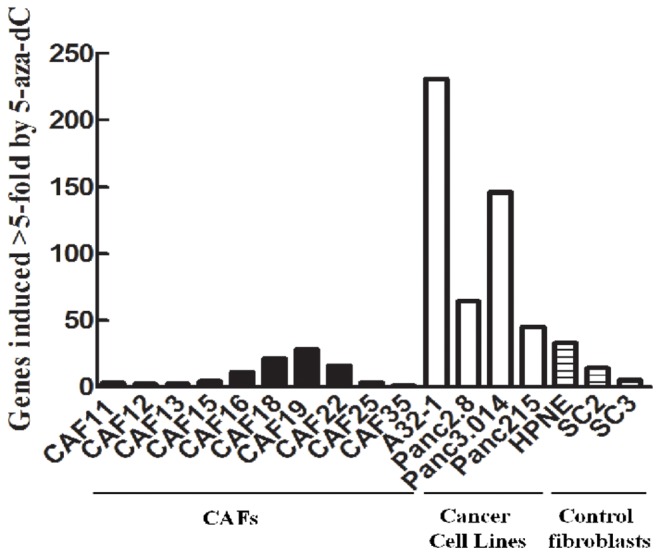
Number of genes induced by 5-aza-dC treatment in individual pancreatic CAFs, control fibroblasts and cell lines.An average of 123±86 genes were induced 5-fold or more by 5-aza-dC treatment in four pancreatic cancer cell lines, 9±10 genes in ten pancreatic CAFs (P = 0.0009) and 17±14 genes in three control pancreatic fibroblast lines.